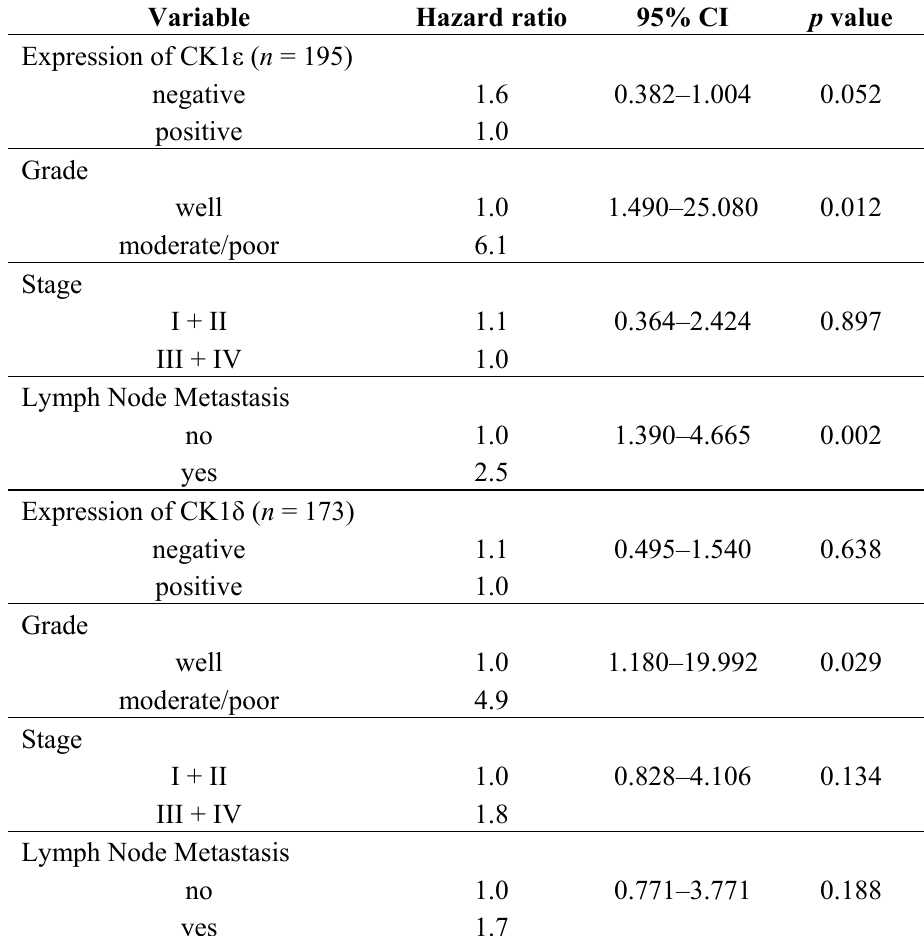
Table 4. Multivariate analysis (Cox regression) of several clinicopathologic indicators of oral